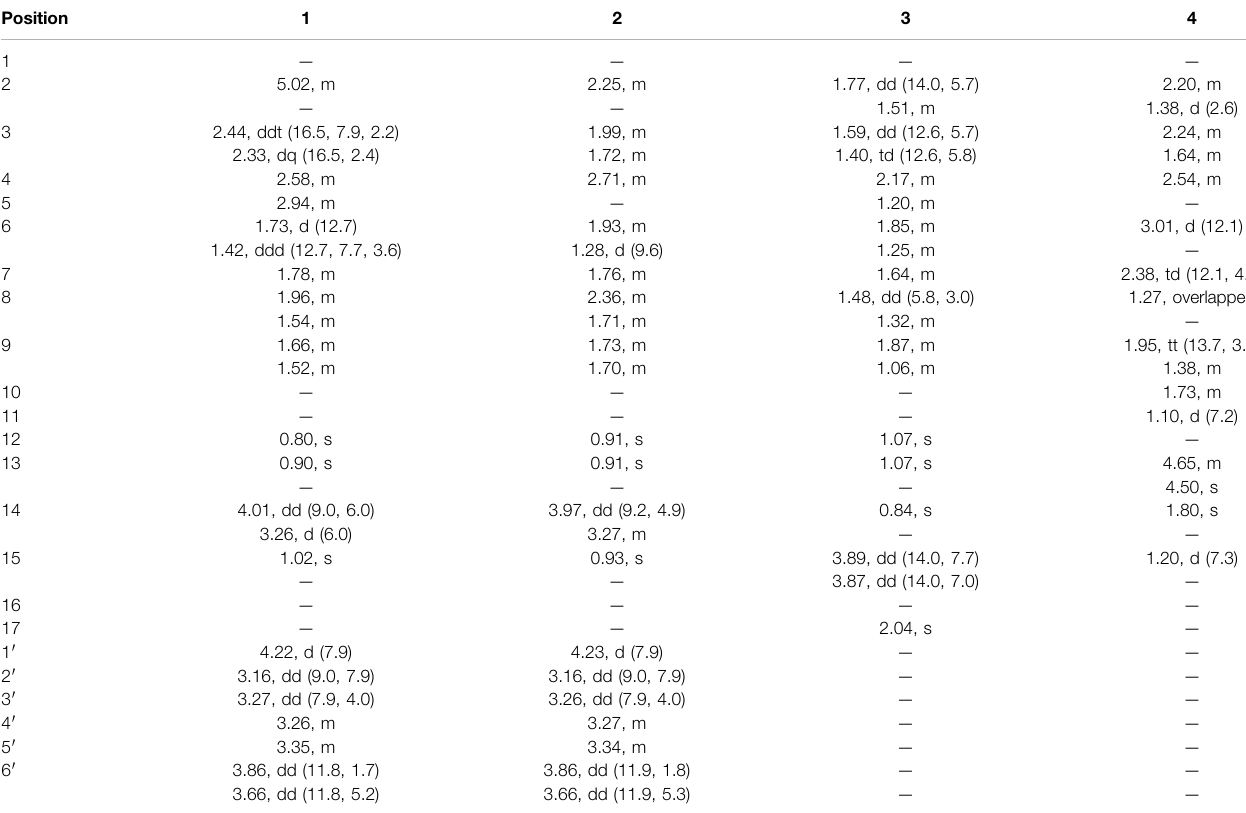
TABLE 1 | 1 H NMR data of compounds 1 and 2 in CD 3 OD and of compounds 3 and 4 in CDCl 3 (500 MHz). Position